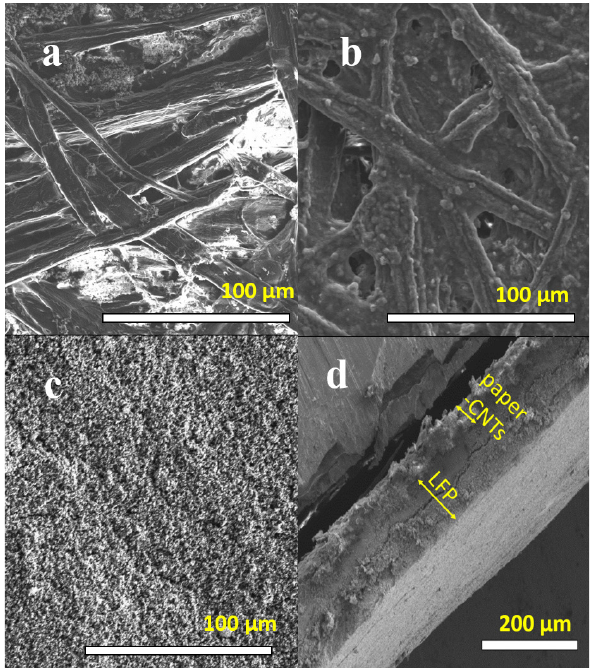
Figure 1: Representative scanning electron micrographs of (a) un- coated paper, (b) paper coated with carbon nanotubes (CNTs), (c) top view and (d) cross-sectional view of LiFePO 4 coated on paper-